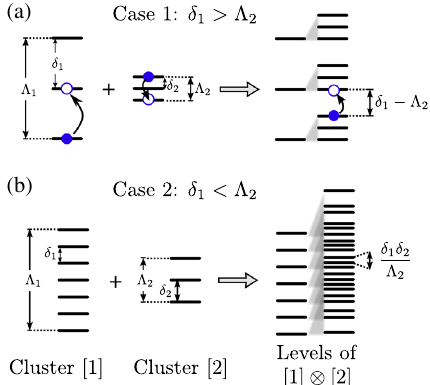
FIG. 4. Two cases for merging resonances. The energy cost for changing the state of one cluster (blue circle to open circle connected by black arrow) can be partially compensated by changing the state of another cluster. The reduced energy penalty, δ E “ flip-flop ” transitions is either δ 12 , for such depending on whether δ 1 ≷ Λ 2 , as shown in panels (a) and (b) ,